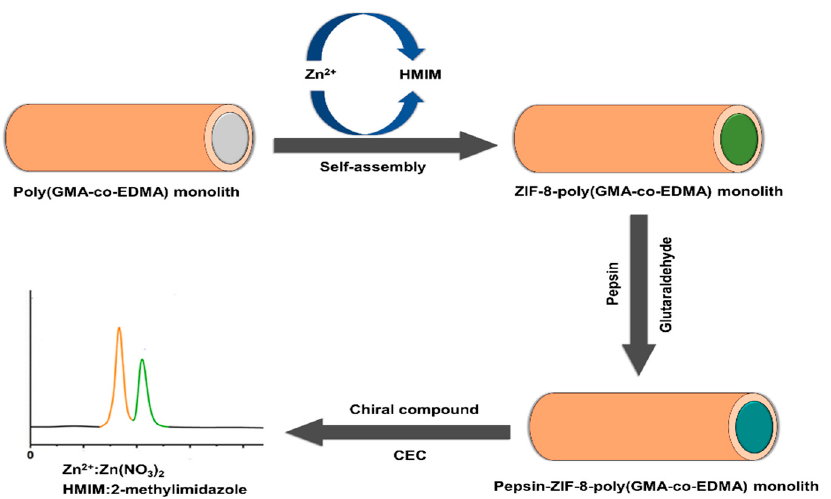
Figure 18. Illustration of the fabrication steps of pepsin-ZIF-8@GMA monolithic column for CEC racemate resolution [160]. Redraw by PowerPoint 365 software.